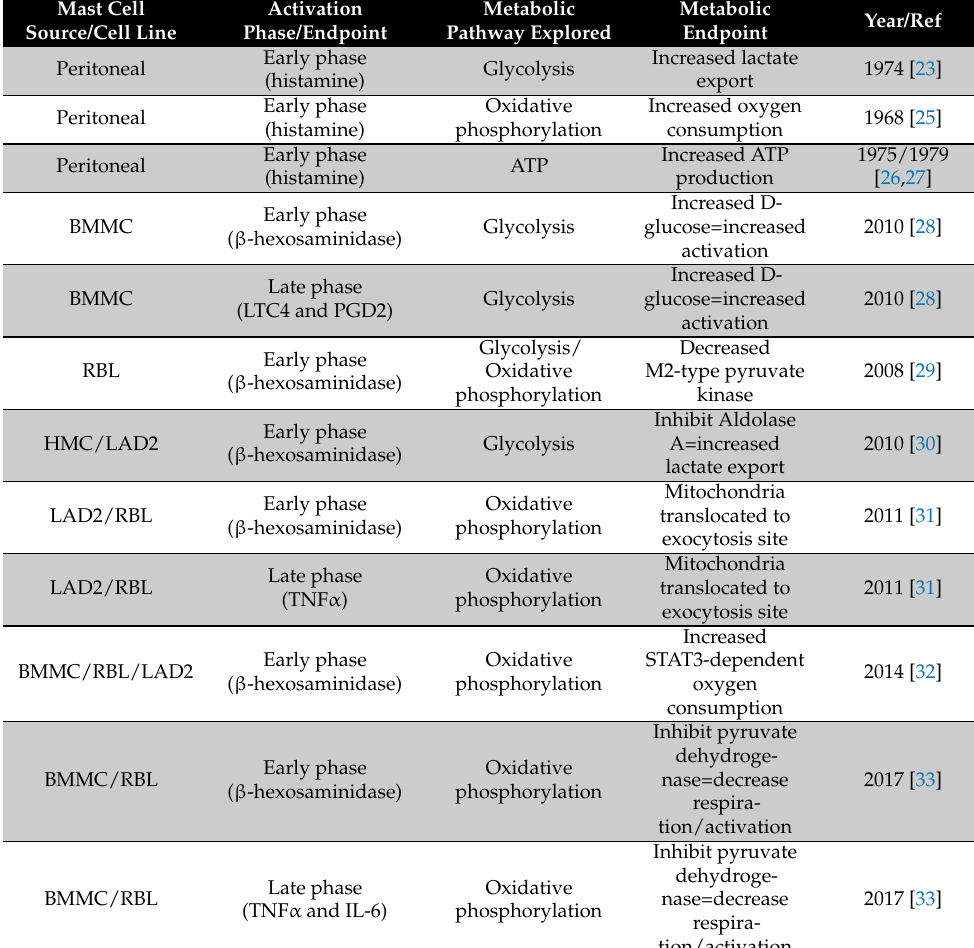
Table 1. Summary of studies exploring energy metabolism changes in IgE mediated mast cell